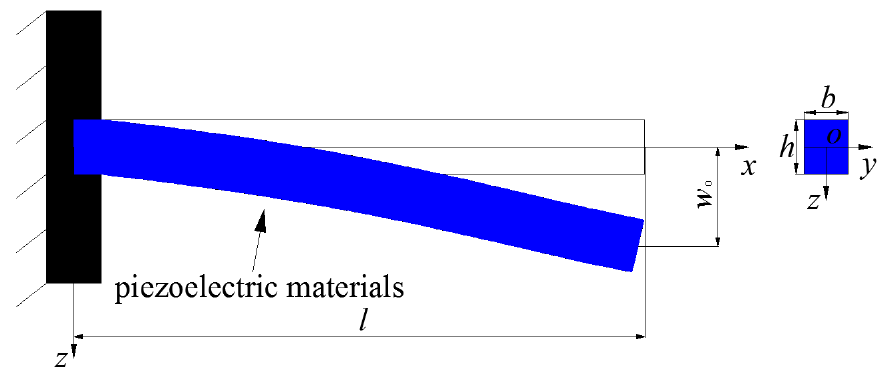
Figure 1. Scheme of the mechanical model of the piezoelectric cantilever beam.